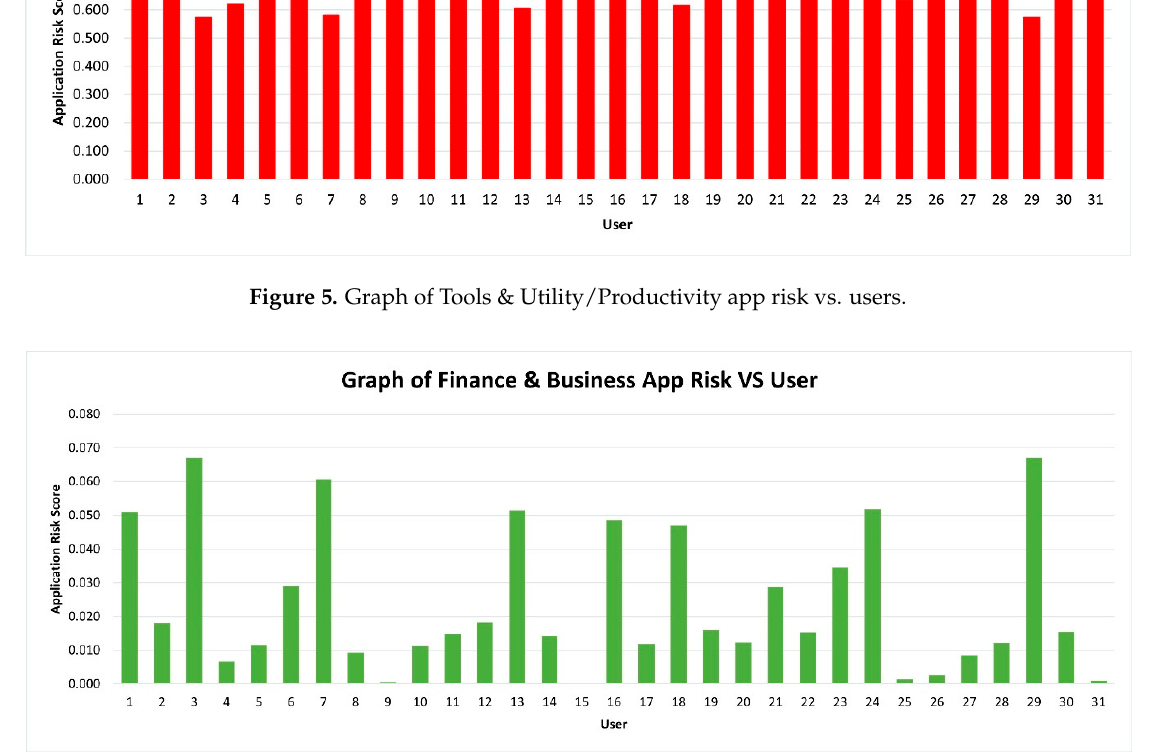
Figure 6. Graph of Finance & Business app risk vs. users.